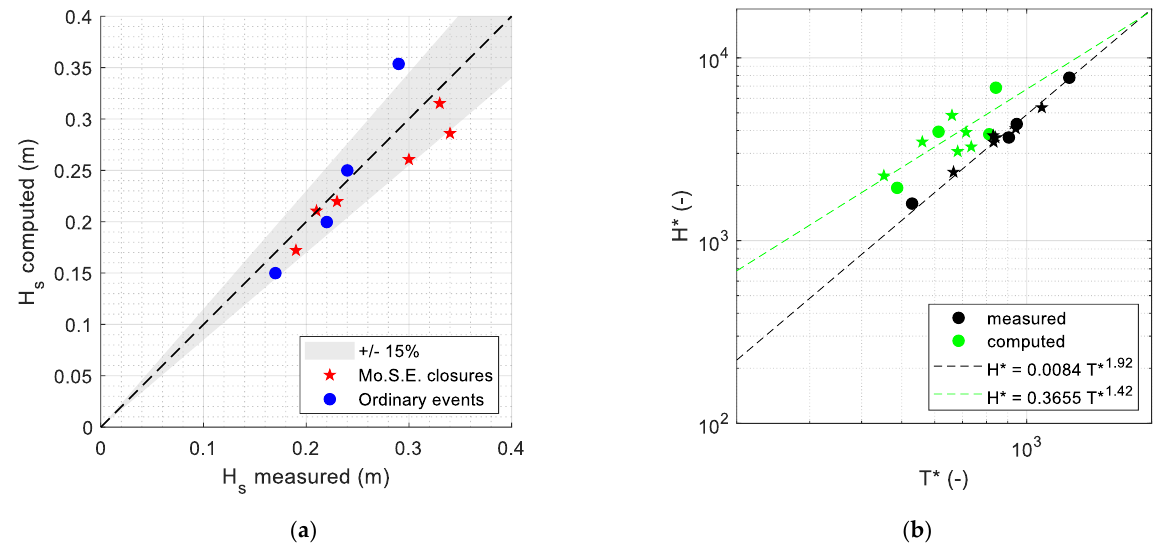
Figure 7. Comparison between the measured and the computed ( a ) significant wave height H S and ( b ) dependency law between the dimensionless wave period T* and the dimensionless significant wave height H* during the ten events: 6 Mo.S.E. closures (stars) and 4 ordinary events (circles).